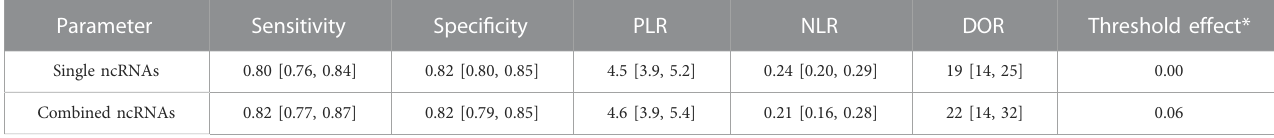
TABLE 4 Diagnostic value of ncRNAs as a panel or single biomarkers.